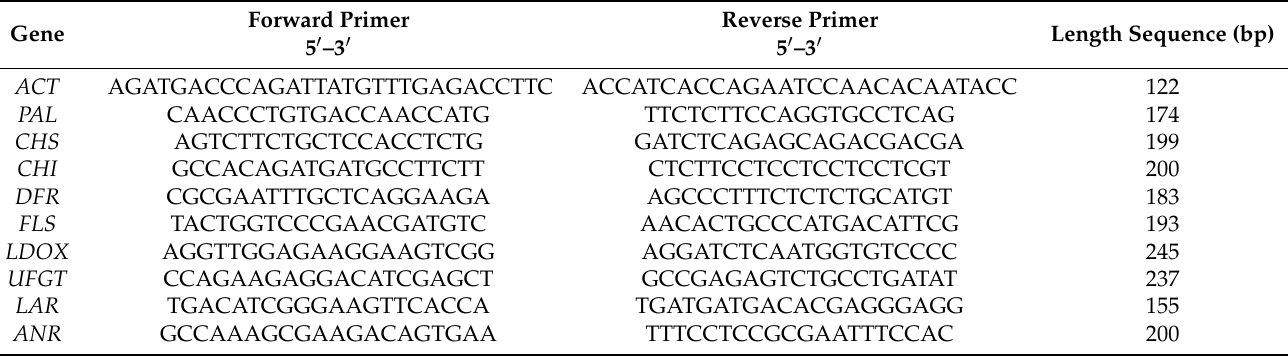
Table 3. Sequence of primers used for RT-qPCR